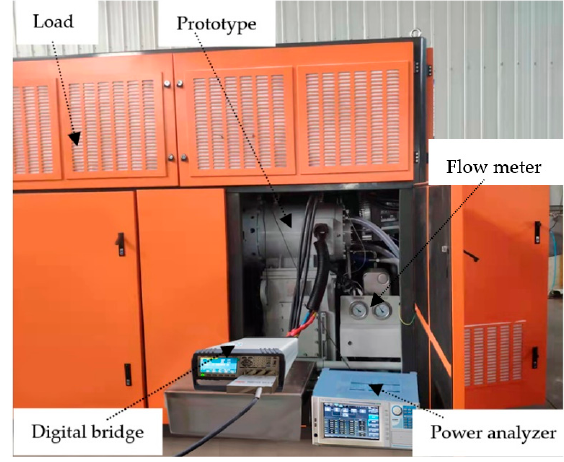
Figure 27. Experimental platform of high ‐ speed motor.